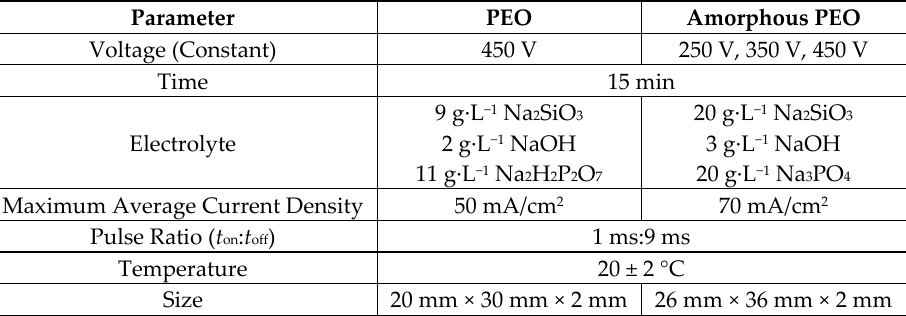
Table 1. Plasma electrolytic oxidation (PEO) processing parameters.